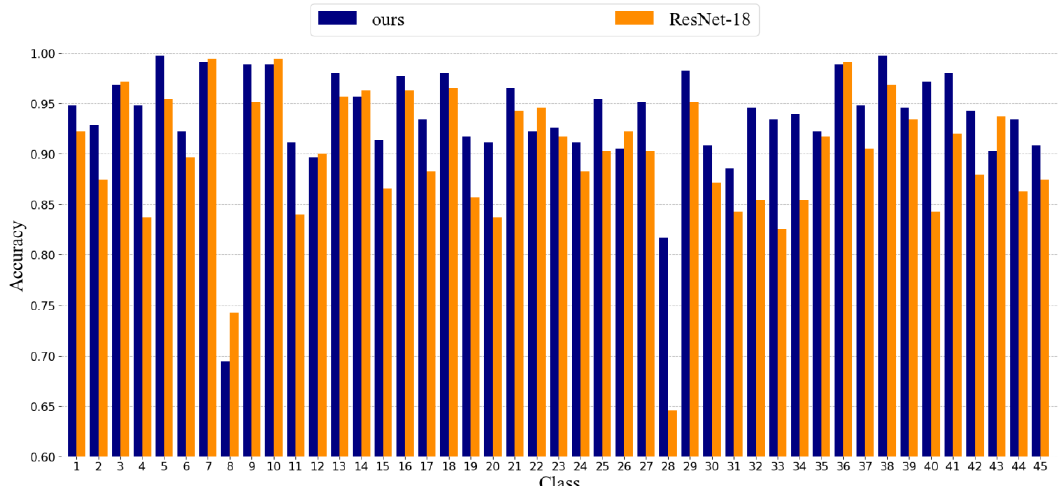
Figure 13. Accuracy in each class of ResNet-18 and MSAA-Net for the NWPU-RESISC45 dataset.